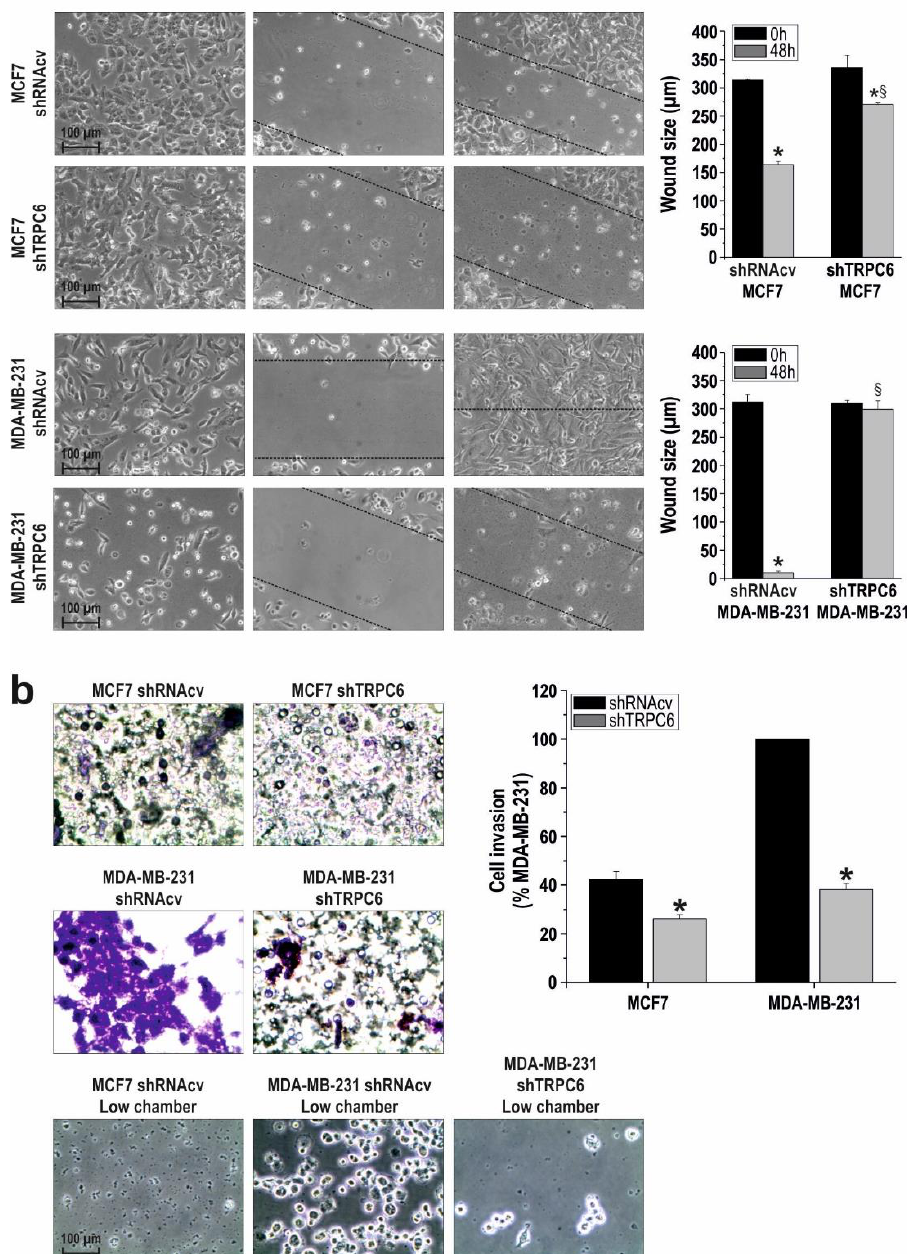
Figure 3. Role of TRPC6 in breast cancer cell migration and invasion. MCF10A, MCF7 and MDA-MB-231 cells were transfected with shTRPC6 or control shRNAcv. Forty-eight hours after transfection cells were subjected to wound healing assay ( a ) or transwell migration assay ( b ) as described in Methods. ( a ) Images were acquired at 0 and 48 h from the beginning of the assay. The dotted lines define the areas lacking cells. The bar graphs represent the wound size, in micrometers, at the different conditions, expressed as the mean ± SEM of three independent experiments. * p < 0.05 compared to the time = 0 h. § p < 0.05 compared to the corresponding time in shRNAcv transfected cells. ( b ) Images show the stained cells as obtained from the transwell migration assay subjected to the different experimental conditions. The bar graphs represent the percentage of cell invasion as compared to MDA-MB-231 cells transfected with shRNAcv, expressed as the mean ± SEM of five independent experiments. * p < 0.05 compared to the corresponding shRNAcv transfected cells. Bottom panels show representative pictures of the invasive cells adhered to the bottom of the lower chamber.